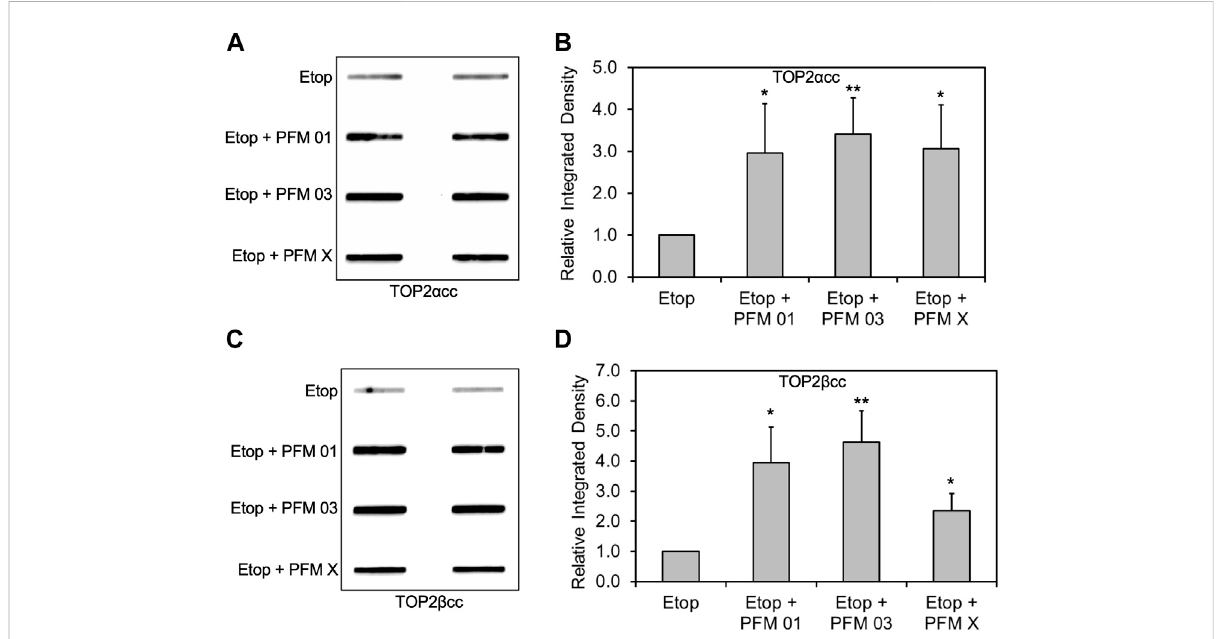
Inhibition of MRE11 endonuclease activity results in accumulation of etoposide-induced TOP2/DNA complexes. RH30 cells were pre-treated with 25 μ MPFM01,25 μ MPFM03,or25 μ MPFMXfor4 h.Etoposide(10 μ M)wasadded,andincubationwascontinuedfor2 h.CellswerethenharvestedforICE assays. (A) Representative ICE assay measuring the levels of TOP2 α cc (B) Densitometric analysis of all assays comparing relative integrated densities of TOP2 α cc signals. Integrated density of TOP2 α cc signal of each group was normalized to that of cells treated with etoposide alone. (C)